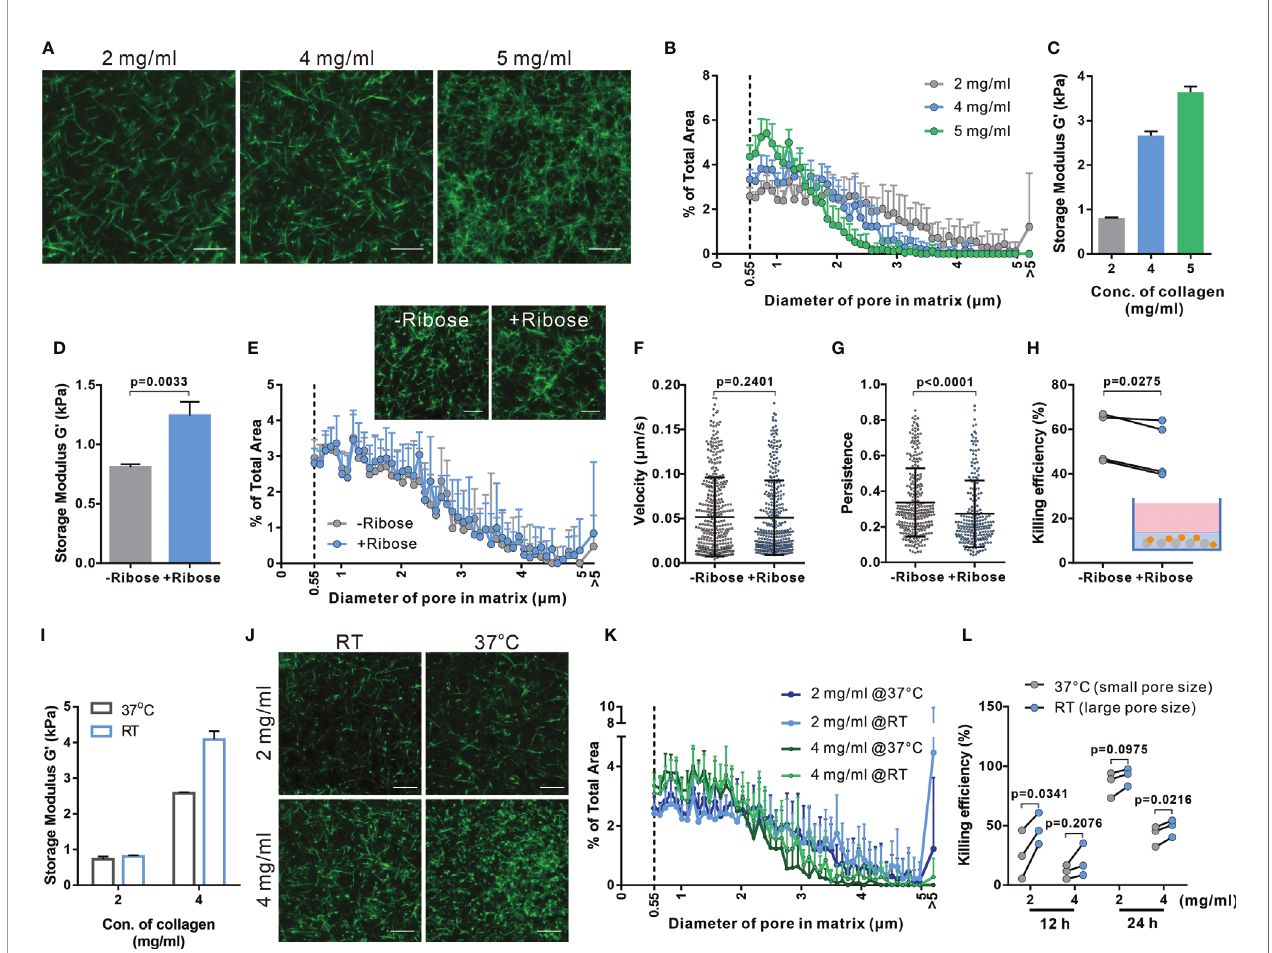
FIGURE 2 | Both enhanced stiffness and reduced pore size contribute to impaired CTL killing ef fi ciency in dense matrices. (A, B) Characterization of porosity in collagen matrices with different densities. Structure of collagen stained with Atto 488 NHS ester was visualized using light-sheet microscopy with a 20× objective (A) . The distribution of pore size in these matrices is shown in (B) . (C) Stiffness of collagen matrices was determined by the storage modulus using rheometer. (D – H) Adding ribose increases stiffness of collagen (2 mg/ml) without affecting the pore size. Stiffness and pore size of the respective conditions is shown in (D, E) , respectively. (F – H) Stiffening collagen leads to reduced CTL killing ef fi ciency in 3D. Hoechst 33342-stained CTLs were embedded in a planar 3D collagen matrix. Migration was visualized using Cell Observer (20× objective) for 30 min (F, G) . Migration velocity and persistence are shown in (F, G) , respectively. To determine killing ef fi ciency, CTLs were embedded with NALM-6-pCasper (E:T=1:1) for 4 hours (H) . (I – K) Pore size is increased by polymerizing collagen at RT. Stiffness of collagen matrices was determined by the storage modulus using rheometer (I) . The structure was visualized using light-sheet microscopy (20× objective) (J) . The pore size at each condition is shown in (K) . (L) Enlarged pore size improves CTL killing in 3D. NALM-6-pCasper cells were embedded in the matrices and CTLs were added from the top (E:T=5:1). Results are presented as Mean ± SD from 2 (A, B, E, J, K) or 3 independent experiments (for F – H , L , results are from 3 donors). One dot stands for either one cell (in F , G ) or one donor (in H , L ). For statistical signi fi cance, the unpaired Student ’ s t-test (D) , the Mann-Whitney test (F, G) or the paired Student ’ s t-test (H, K) was used. Scale bars are 10 m